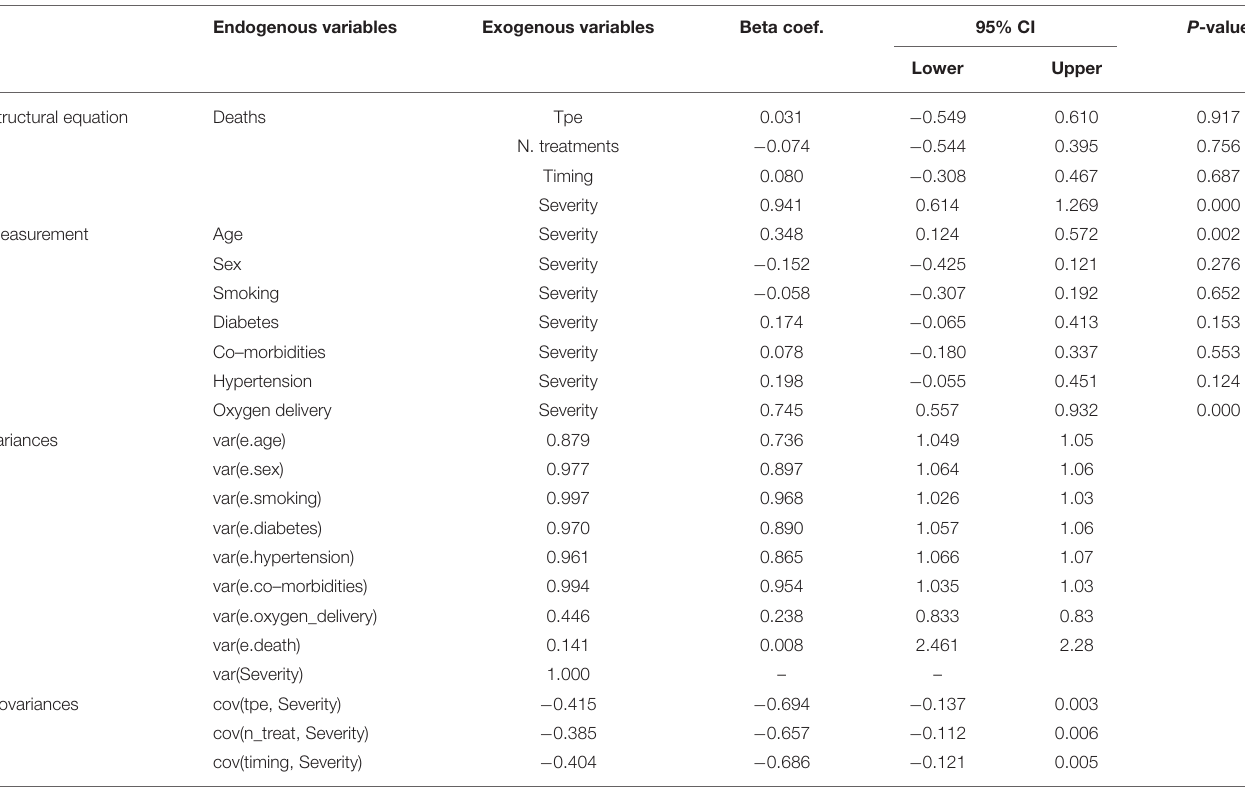
TABLE 3 | Four groups of SEM results (structural equations, measurement, variances, covariances) for the analysis of mortality of critically ill patients with COVID-19 after therapeutic plasma exchange (TPE).